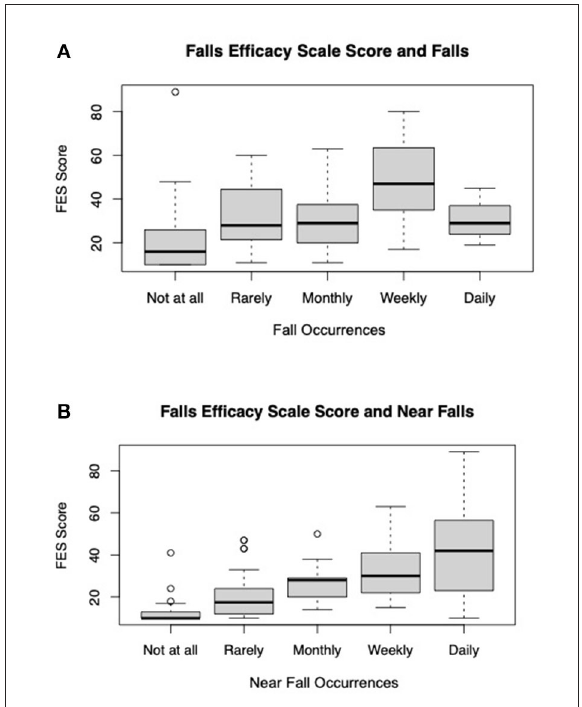
FIGURE2 Average FES score by (A) average FES score by self-reported falls and (B) average FES Score by self-reported near falls ( n = 115).